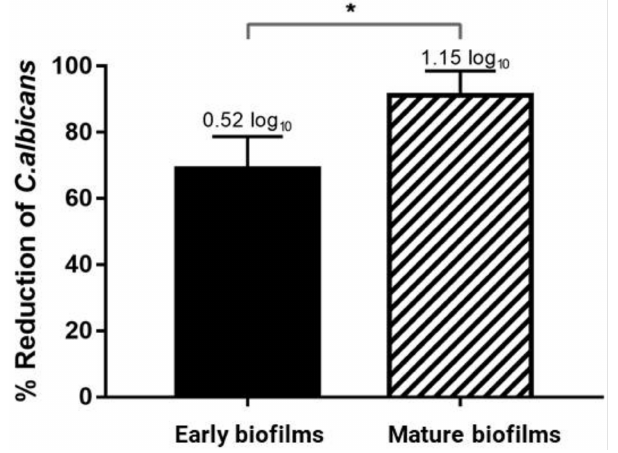
Figure 4. Percentual reduction of C. albicans early and mature biofilms biofilm in the presence of PF (Probiotic Film). Each column represents the mean of three independent experiments, each performed in triplicate ( n = 9), the bars represent the standard deviation. Numbers above columns represent the decimal reduction (DR) The asterisk indicates statistically significant difference (* p = 0.03) between early and mature biofilms, according to t